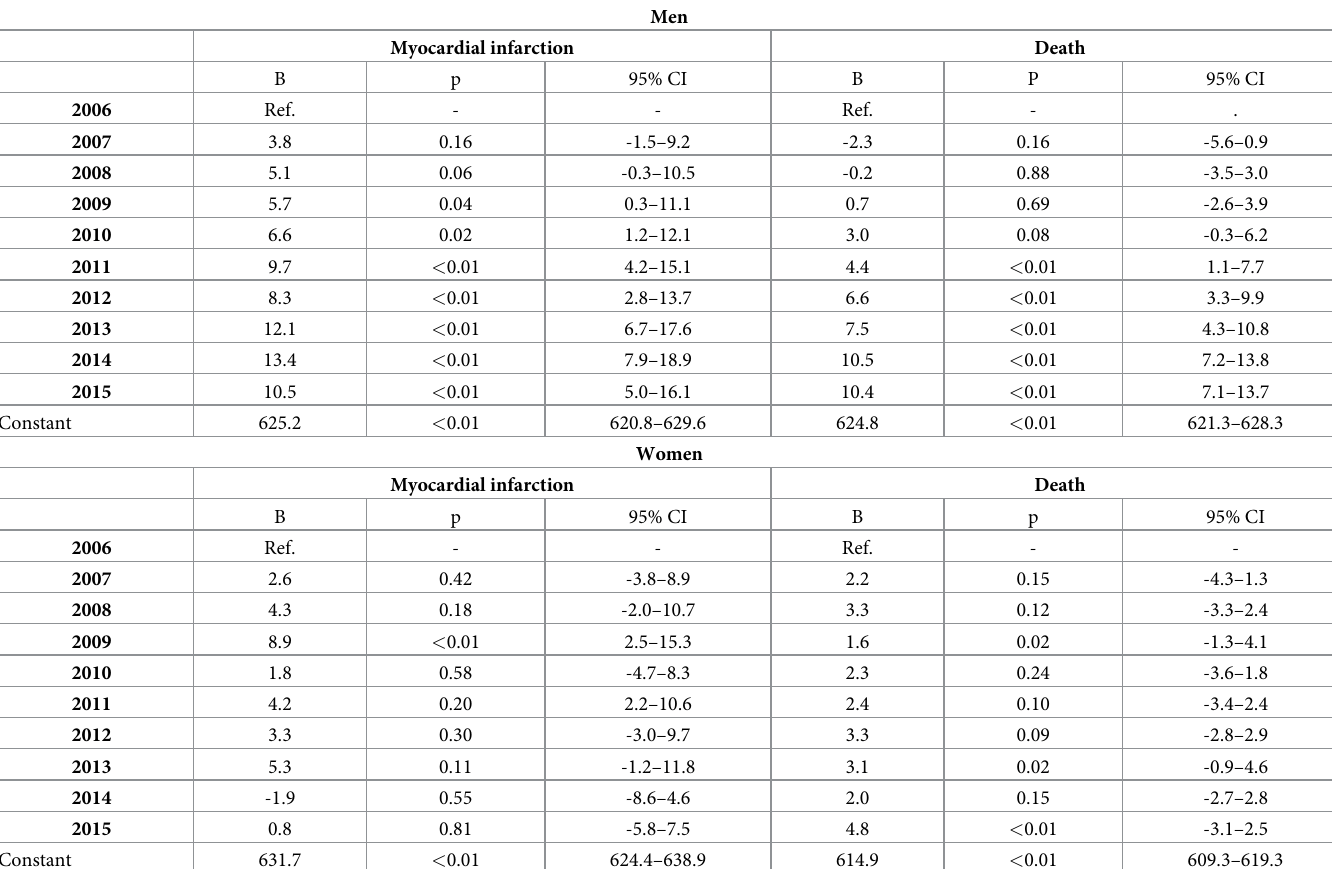
Table 4. Changes of age at onset of myocardial infarction and at death in months in women and in men in terms of months: Effect sizes and confidence intervals based on 1000 bootstrap